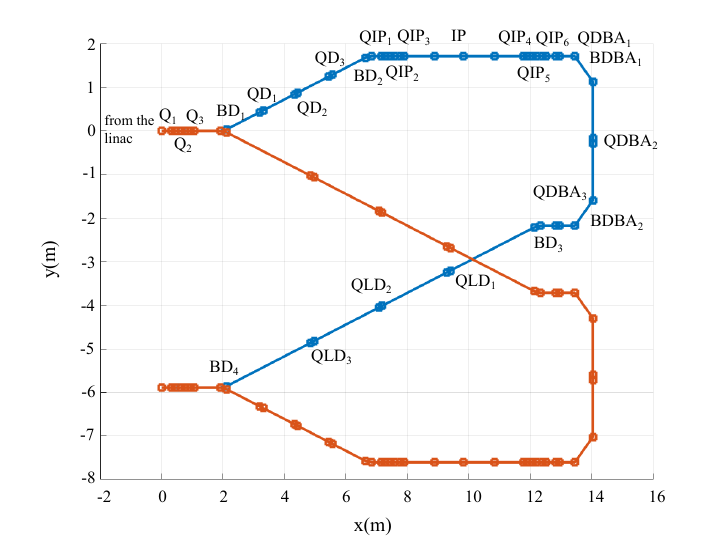
Figure 4. BriXs top view with floor coordinates of the beam line magnetic elements.